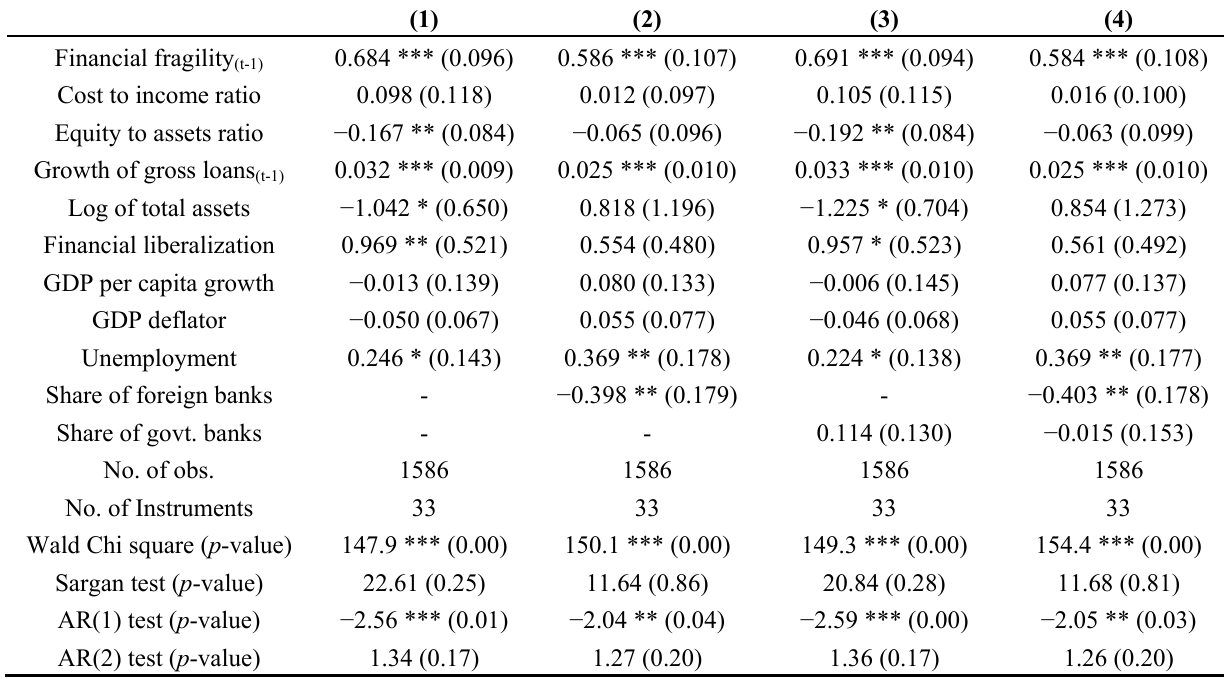
Table 5. Dynamic panel estimation of financial fragility with financial